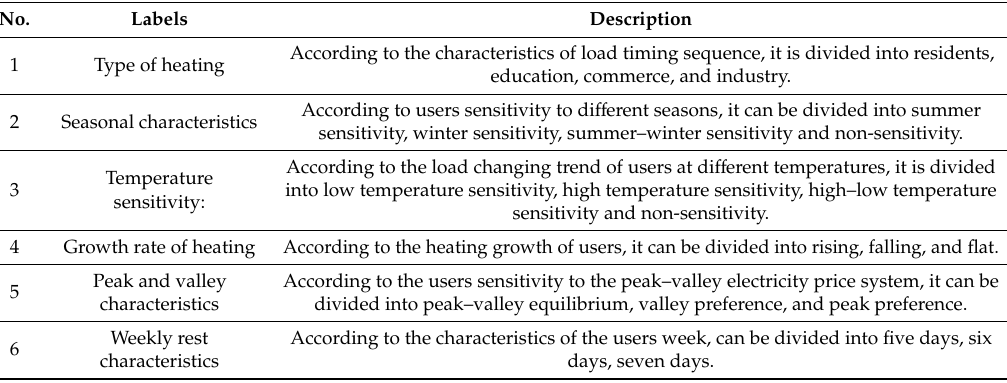
Table 1. Users label